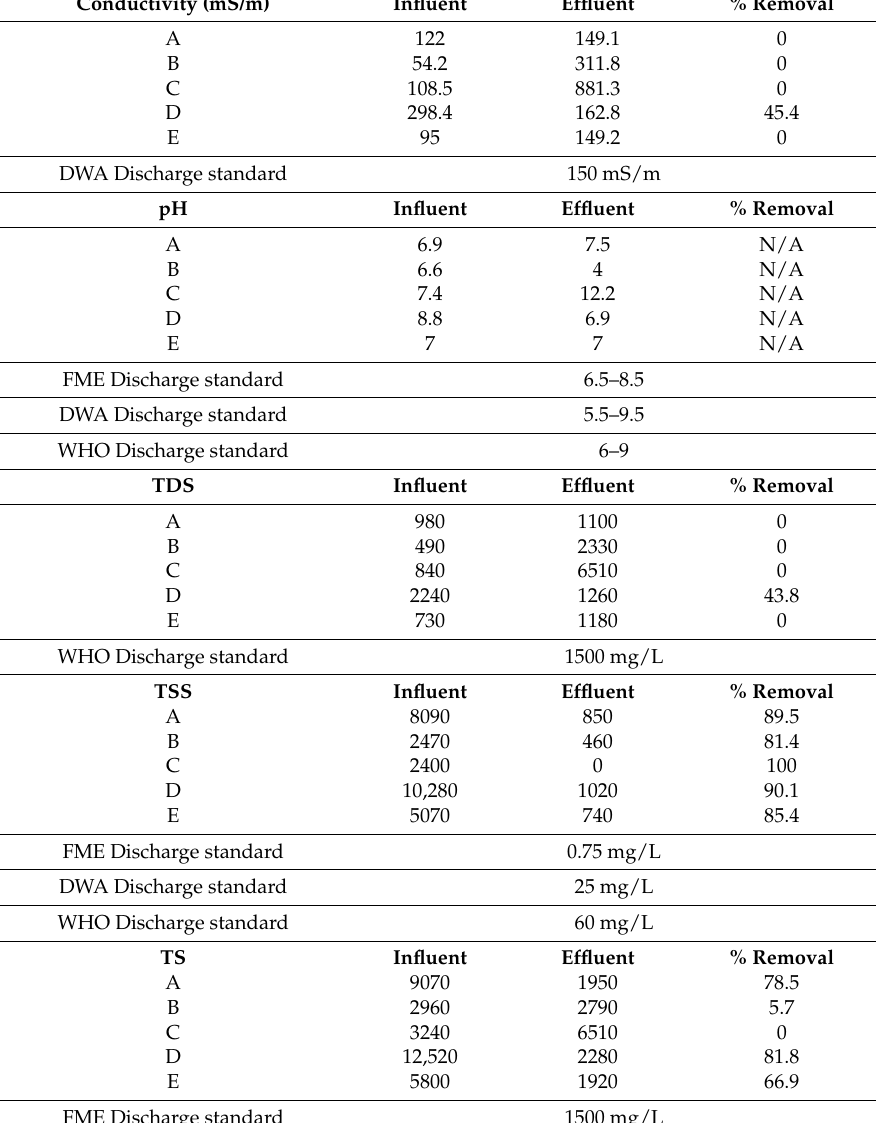
Table 3. EC, pH, TDS, TSS and TS levels of the effluents of the study